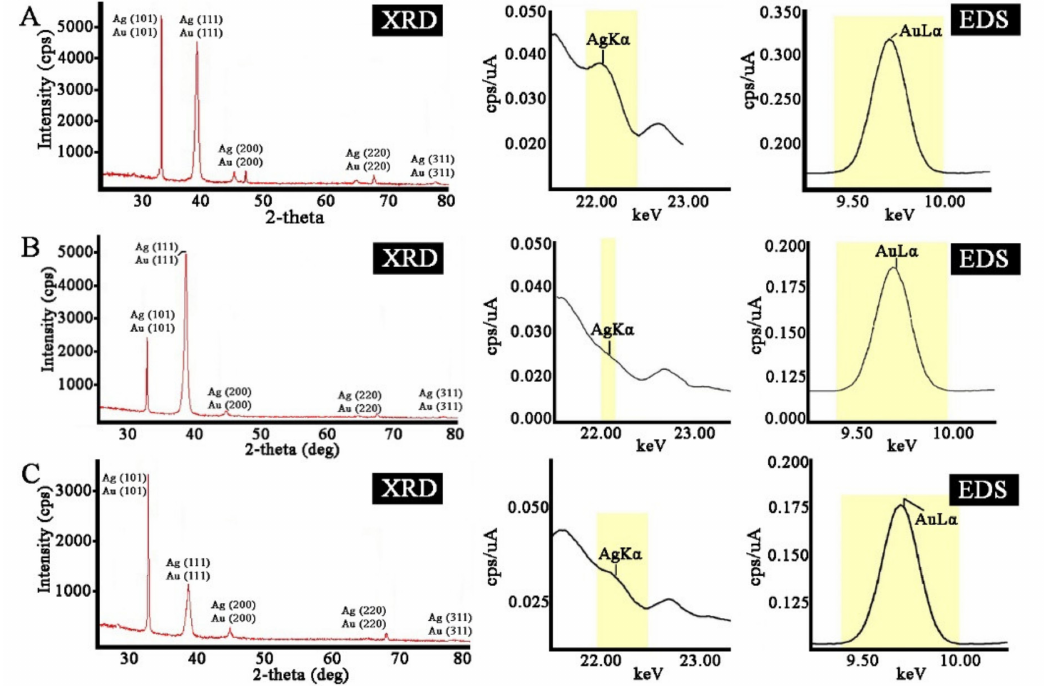
Figure 8. X-ray diffraction (XRD) and energy dispersive X-ray (EDX) analysis of bimetallic Ag/Au NPs synthesized with L . erythrorhizon callus extract. ( A )—Ag/Au (4:1) NPs, ( B )—Ag/Au (1:1) NPs, ( C )—Ag/Au (1:4)